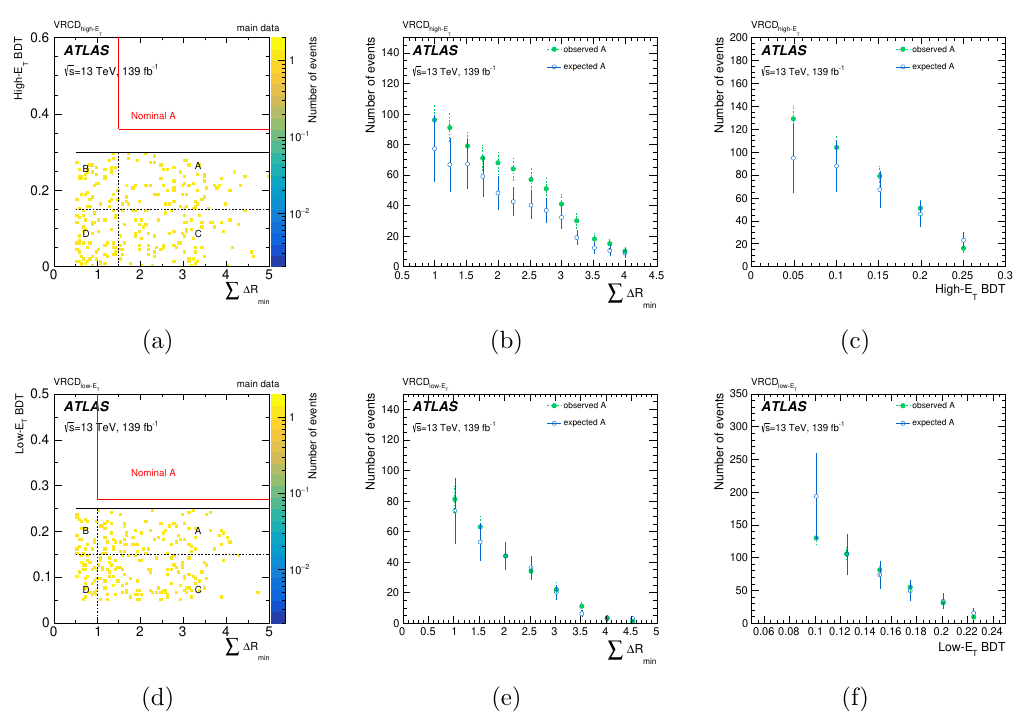
Figure 9. (a) The per-event BDT vs P ∆ R min (jet, tracks) distribution for the main dataset in the VRCD high- E validation region. Region A in the nominal high- E T selection is shown for reference. T Also shown is a comparison of the observed and expected events in region A of this VR. The x -axis shows the different (b) P ∆ R min (jet, tracks) and (c) BDT boundaries used to test the ABCD method. Statistical uncertainties are shown in (b) and (c). Panels (d,e,f) show the equivalent distributions in the VRCD low- E validation T